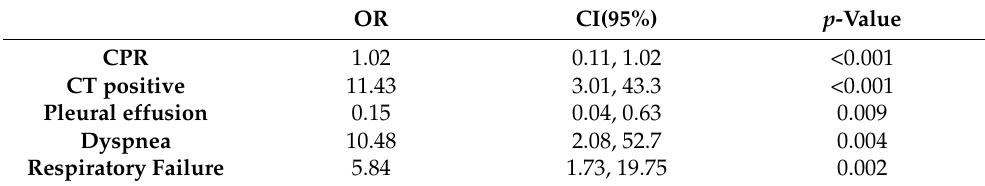
Table 2. Logistic regression model. OR: Odd ratio; CI(95%): Confidence interval at 95%. CPR: C-Reactive Protein; CT: